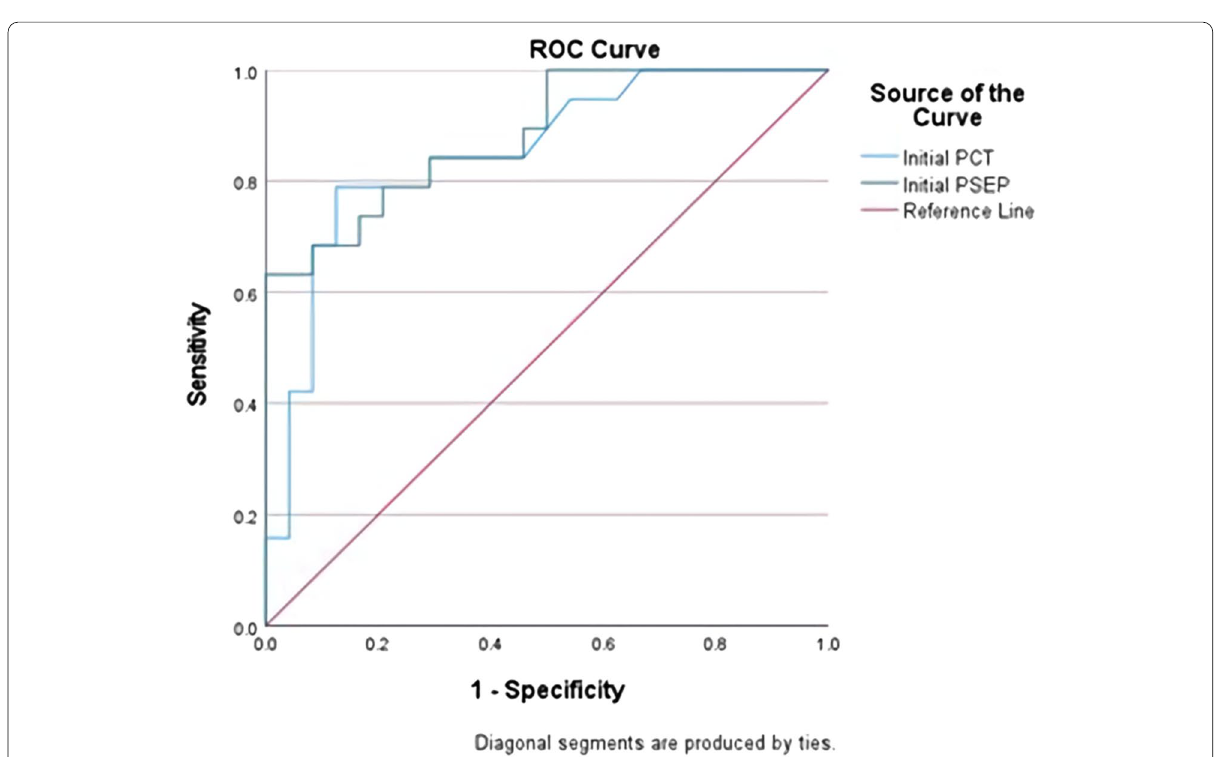
Fig. 1 ROC Curve of PCT and